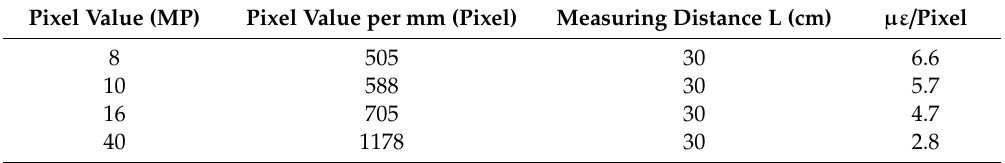
Table 2. Pixel values per mm and actual strain value represented by each pixel for different smartphones. Pixel Value